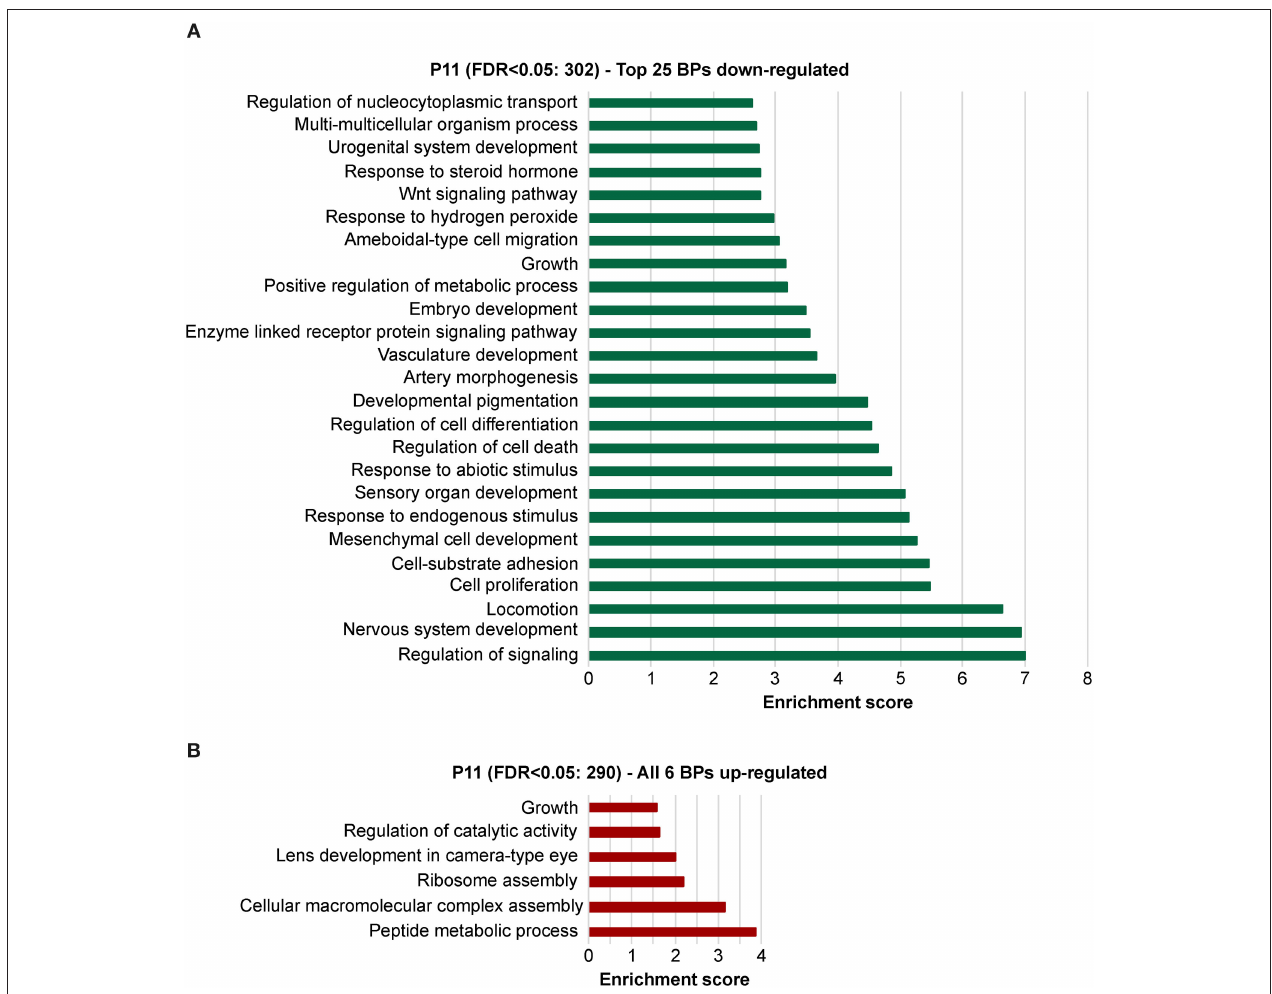
FIGURE 2 | Identification of the biological processes underlying the effect of the deletion of Bbs8 at P11 via gene ontology analysis. Top 25 significant Biological processes (BPs) among the inhibited transcripts (A) and the 6 induced (B) in Bbs8 − / − vs. Bbs8 + / + . The Enrichment score for each BP cluster is plotted on the